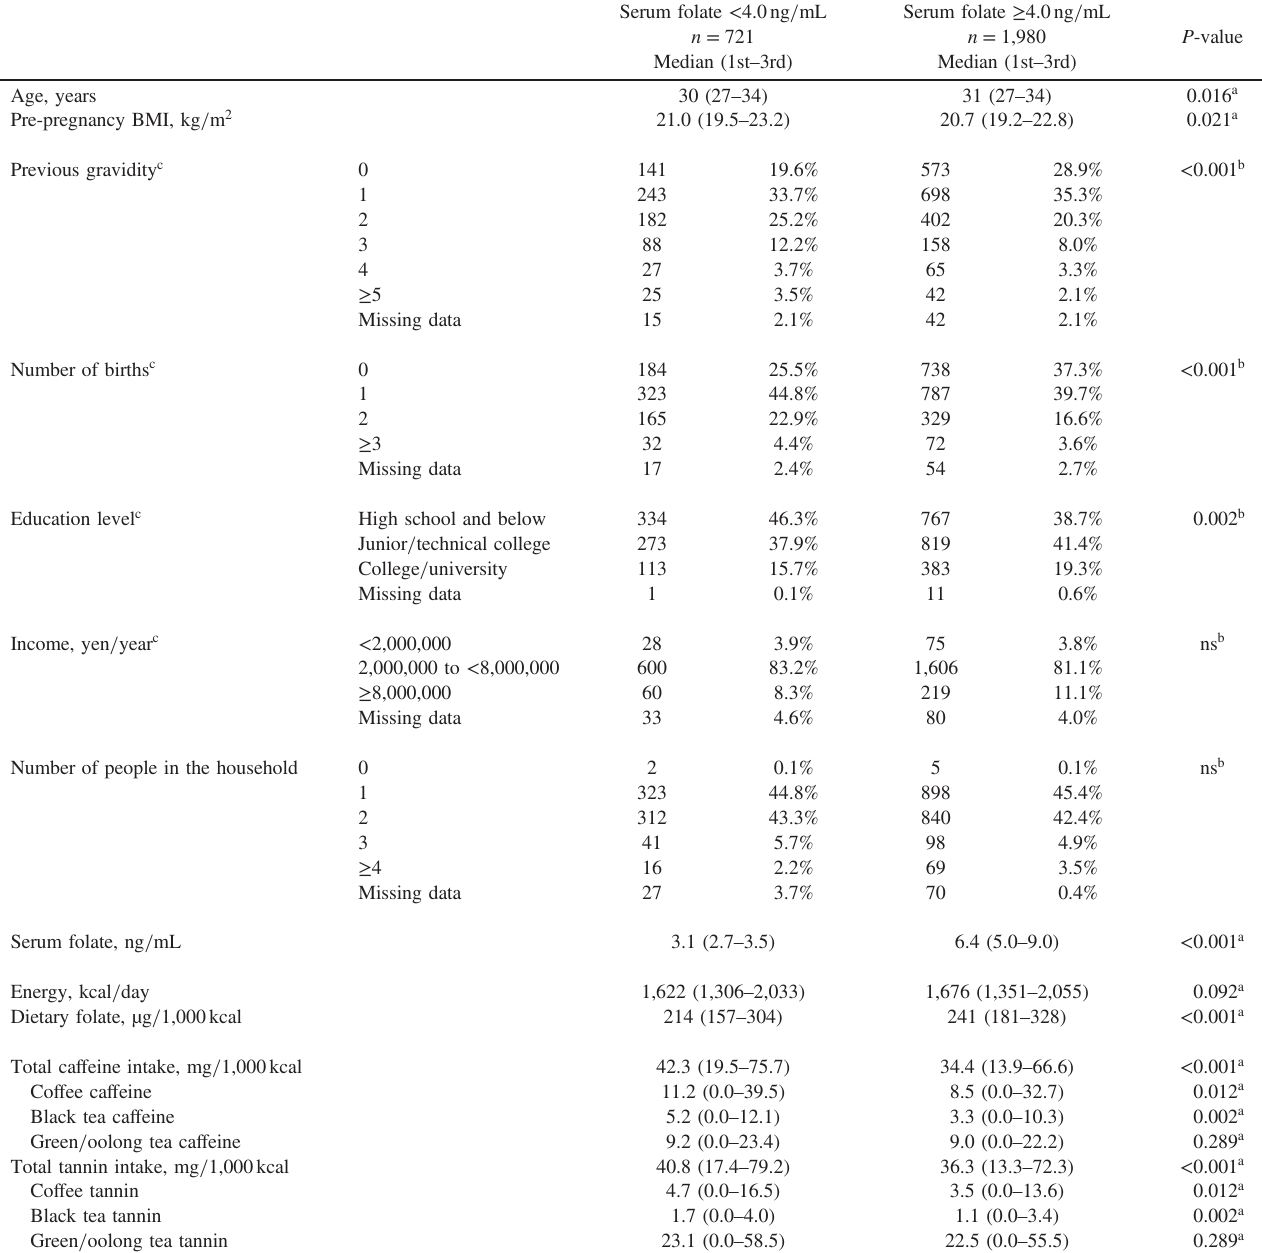
Table 1. Comparison of the characteristics, food intakes, serum folate levels, and ca ff eine or tannin intakes between pregnant Japanese women in the low-folate and normal-folate groups ( n =